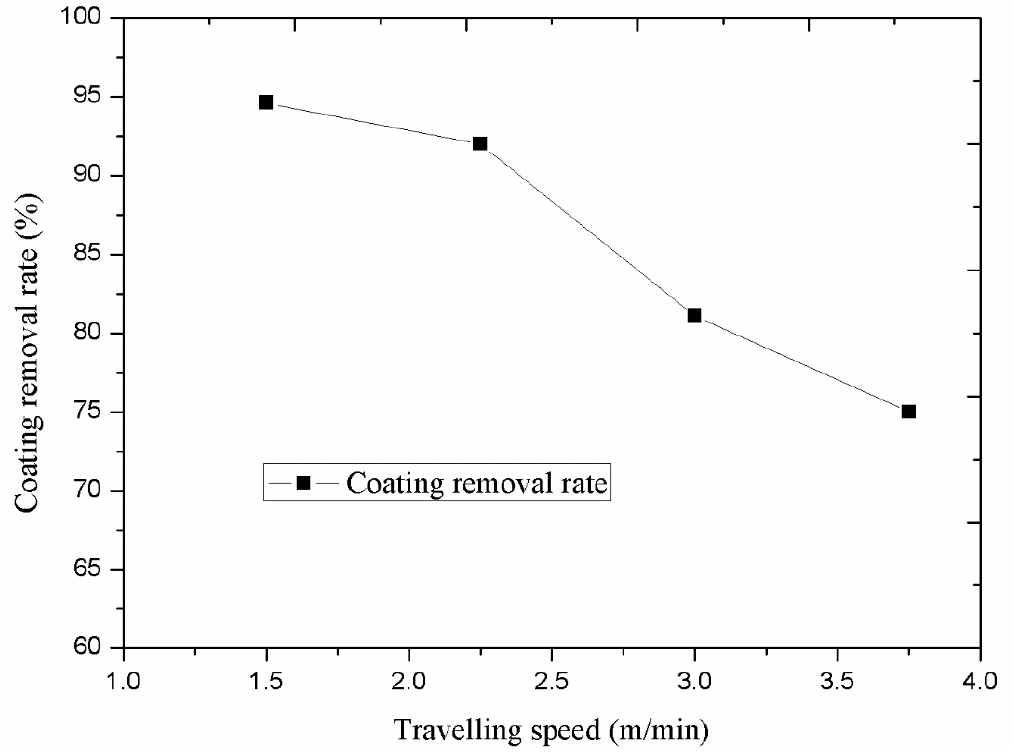
Figure 19. Coating removal rate for the three pressure levels.